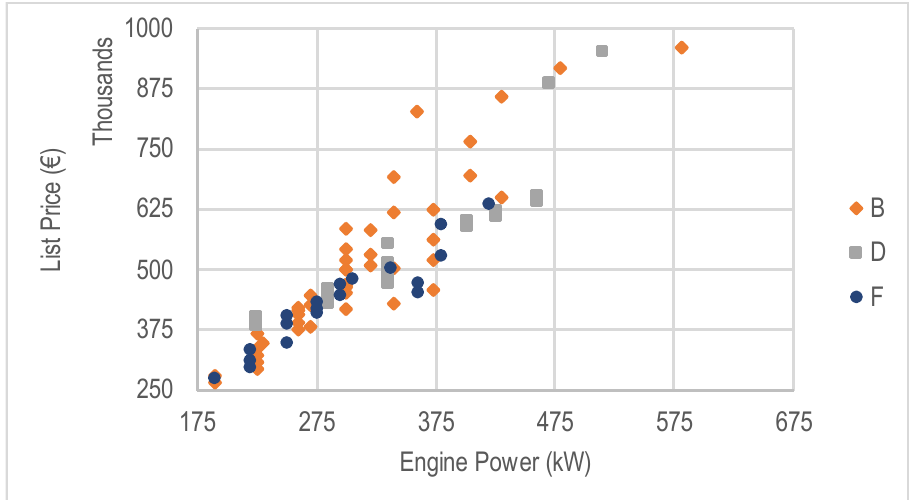
Figure 2. Grain harvesting combine list prices in Germany.